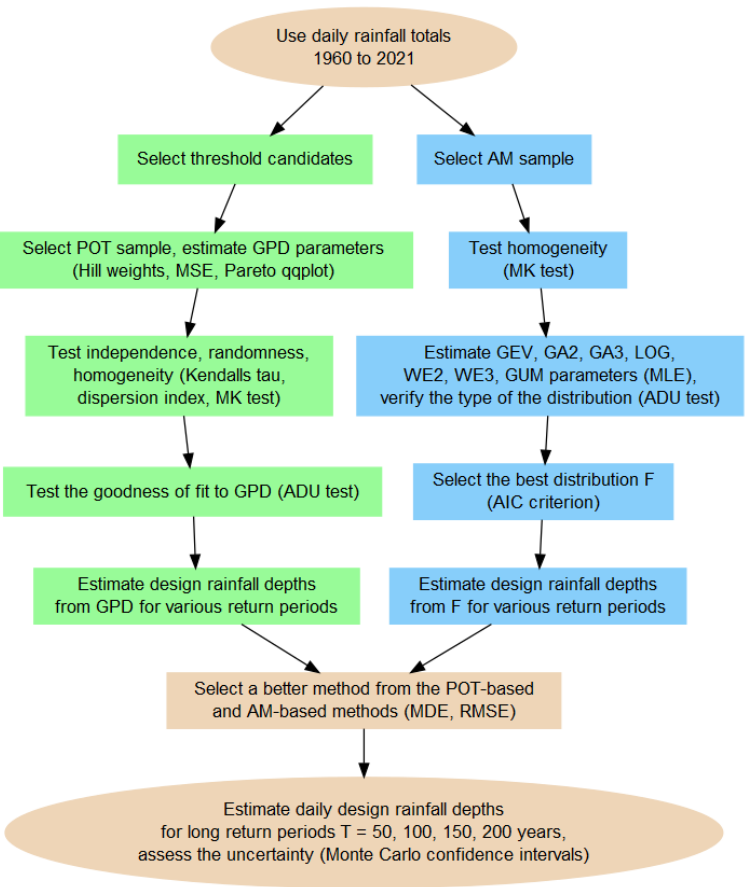
Figure 2. Flow diagram that visualizes the consecutive steps in the POT-based estimation (the left branch) and in the AM-based estimation (the right